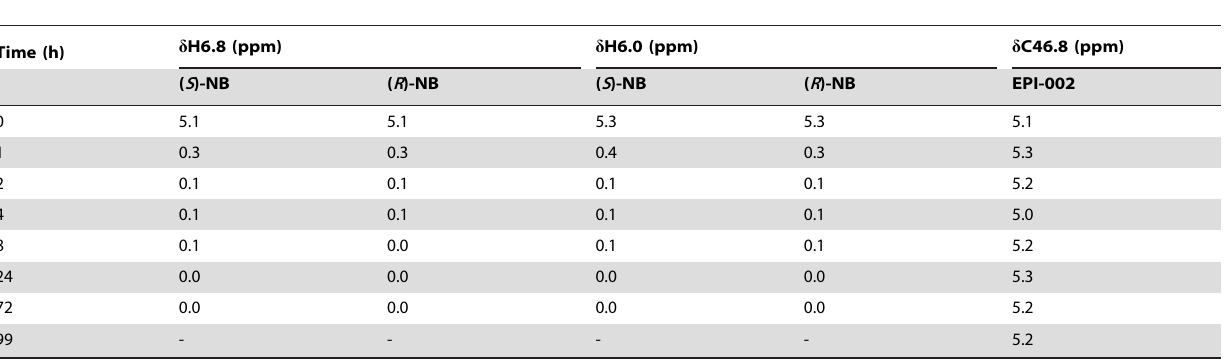
Table 1. Integral Value of ( S )-, ( R )-Niphatenone B, and EPI-002.